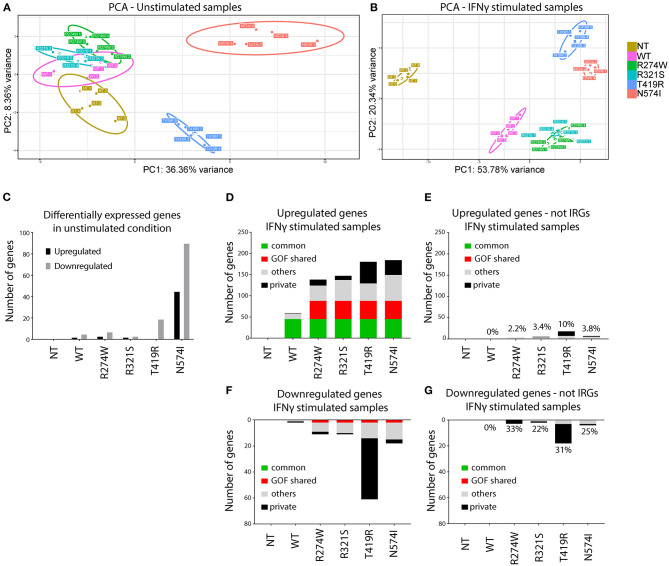
Principal component analysis (PCA) and number of de-regulated genes before and after IFNγ stimulation. (A) PCA of unstimulated samples. (B) PCA of IFNγ stimulated samples. Clustering of the different replicates per condition was observed and designated with different color codes. The colored circles indicate the 95% confidence ellipse for each cluster. (C) Number of genes differentially expressed in unstimulated samples compared with non-transduced U3A−/− cells (NT). (D) Number of up-regulated genes (IFNγ stimulated condition was compared with the unstimulated condition for each condition). (E) Number of up-regulated genes present in (D) not previously reported as IRGs. On top of the bars, the percentage of non-IRGs among the total up-regulated genes. (F) Number of down-regulated genes (IFNγ stimulated condition was compared with the unstimulated condition for each condition). (G) Number of down-regulated genes present in (F) not previously reported as IRGs. On top of the bars, the percentage of non-IRGs among the total down-regulated genes. Indicated in green, genes that are commonly overexpressed by STAT1 WT and all GOF mutants. In red, genes overexpressed in all GOF mutants. In black, genes expressed only by that specific mutant. In gray, genes that are non-private or non-common WT or GOF. Here we plotted genes that showed at least 2-fold up- or down-regulation compared to their unstimulated condition (p < 0.01).